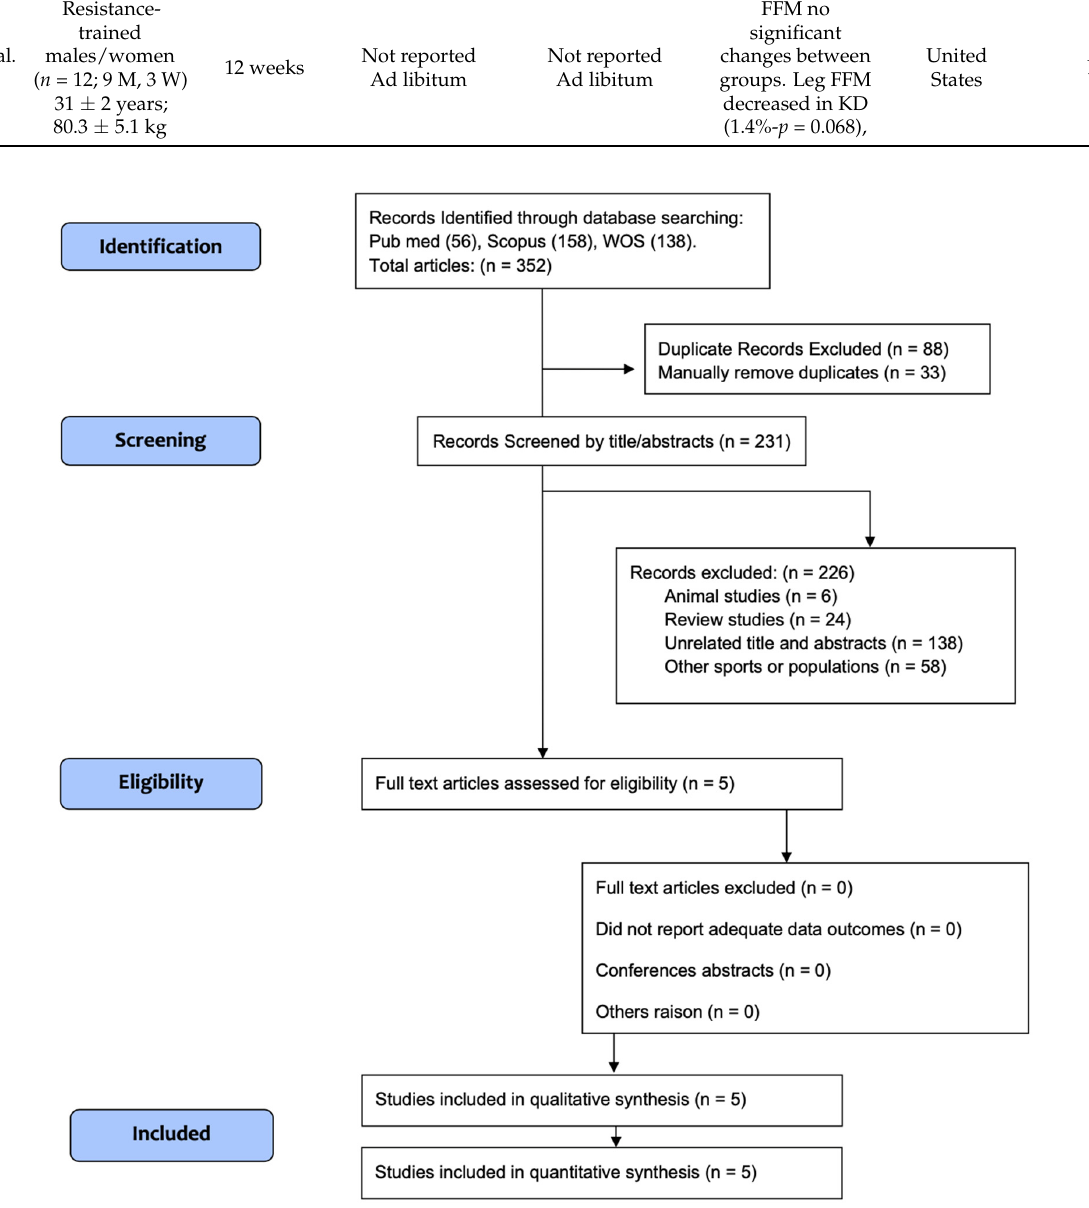
Figure 1. CONSORT